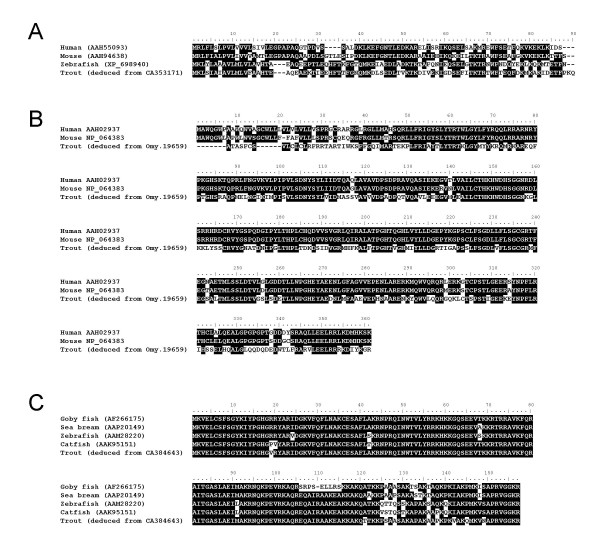
Amino acid sequence alignment of rainbow trout APOC1 (A), MR-1 (B), and RPL24 (C) with cognate vertebrate forms. For each target species, the GenBank accession number of the protein is indicated.